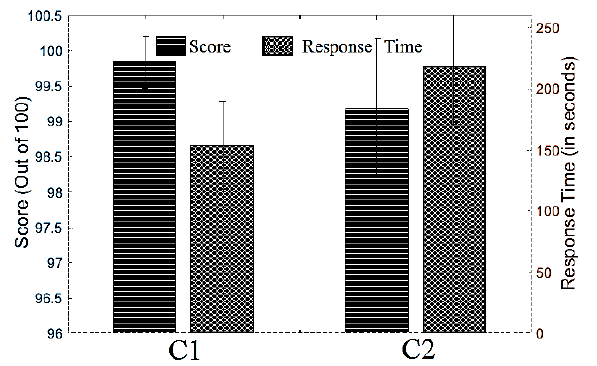
Fig. 12 Average performance metrics for pDSST for the 2 age